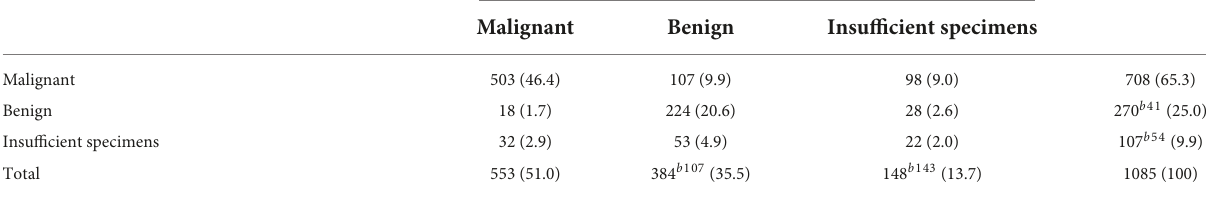
TABLE 2 Pathological classification of cutting and